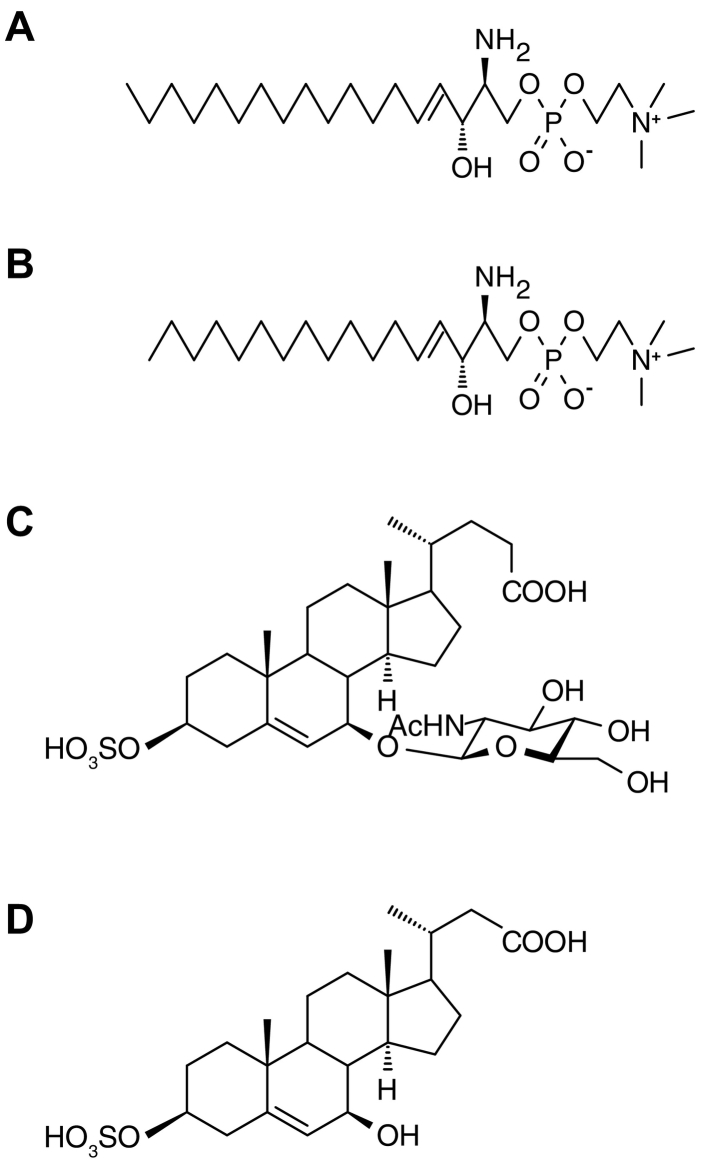
Chemical structures of compounds used in this study. (A) d-erythro-sphingosylphosphorylcholine (synthetic, SPC); (B) sphingosylphosphorylcholine (C17 base, ISSPC); (C) 3β-sulfooxy-7β-N-acetylglucosaminyl-5-cholen-24-oic acid (SNAG-Δ5-CA); (D) 3β-sulfooxy-7β-hydroxy-23-nor-5-cholenoic acid (ISBile acid).